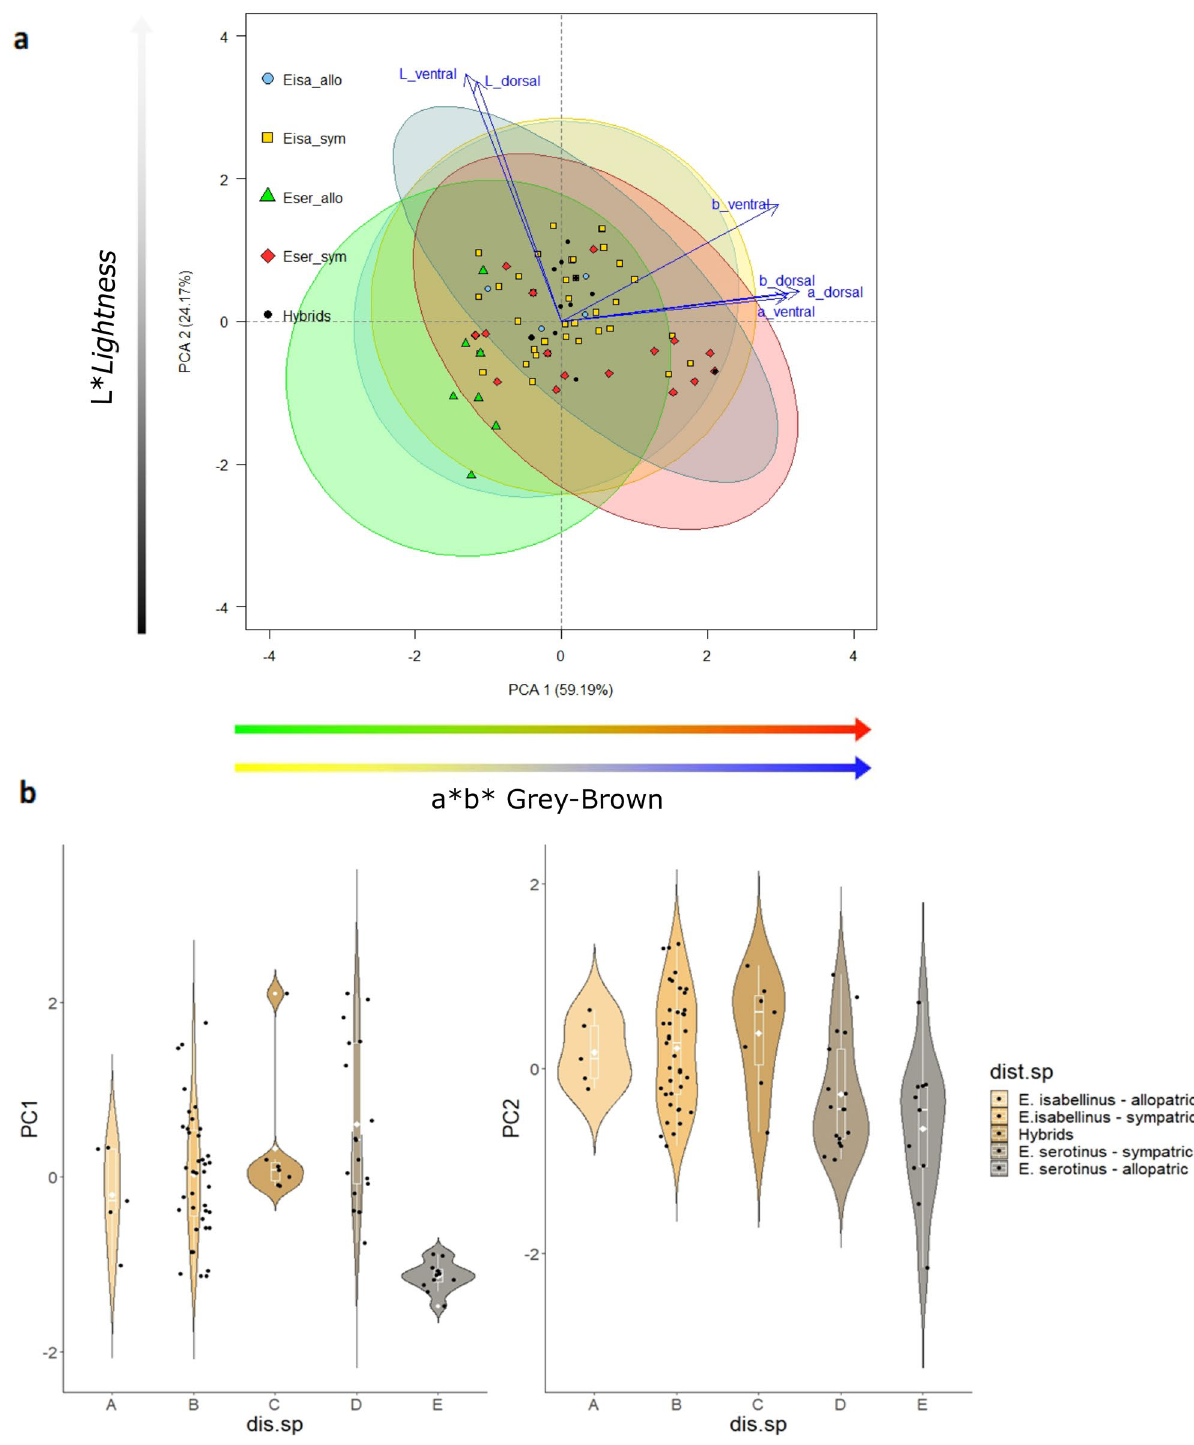
Figure 3. Principal Component Analyses of colour variables. Positioning of each individual in the two- dimensional space defined by the PCA main components retained and their position relative to the original dorsal colour variables ( a ). The violin plots represent E. isabellinus (allopatric and sympatric), E. serotinus (allopatric and sympatric) and Hybrids PCA scores compared to dorsal a*b* Grey-Brown (PC1 Colour) and dorsal L* lightness (PC2 Colour) ( b ). Within violin plots, white solid lines boxplots include medians (horizontal white line) and averages (white dot); boxes and vertical white lines indicate quartiles and ranges (excluding outliers), respectively. Acronyms are available in Table 1 (dist.sp: species